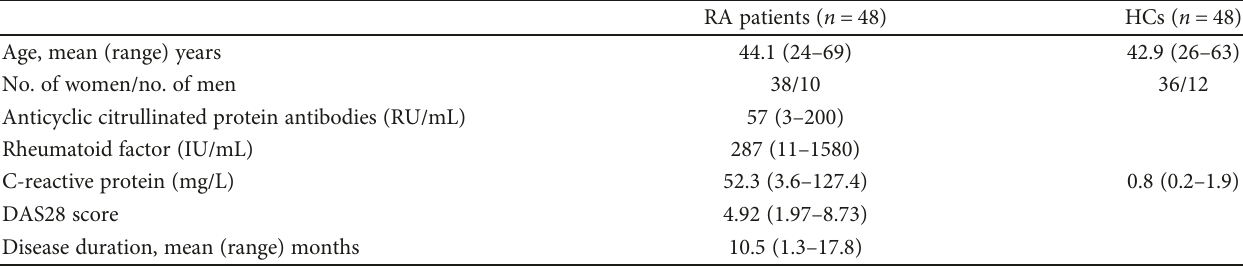
Table 1: Demographic and clinical characteristics of patients with RA and HCs. RA patients ( n = 48